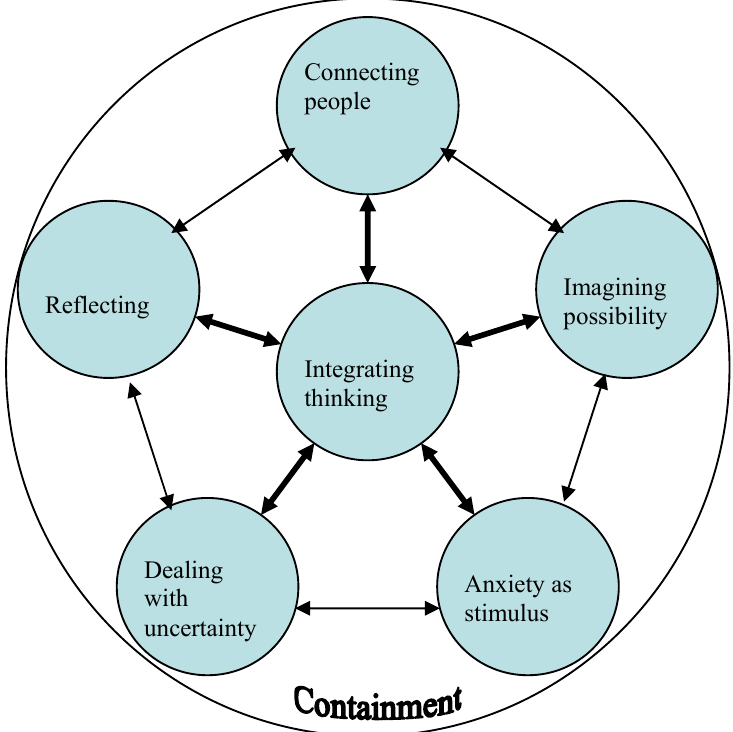
Figure 1. Key aspects of a compelling space (Howatson-Jones, 2010b). Used with kind permission from Learning